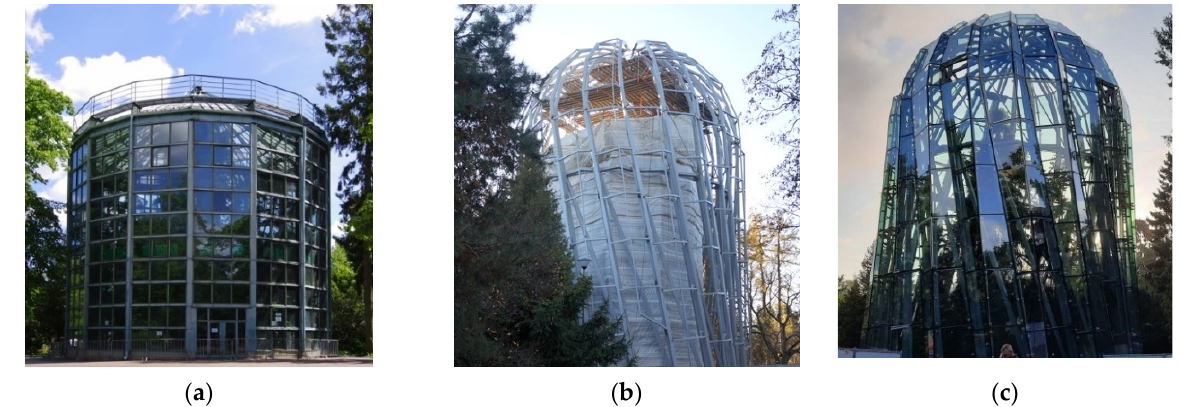
Figure 2. ( a ) Palm house prior to its reconstruction, 2017; ( b ) during the reconstruction, 2018, measurement and construction process inspection period; ( c ) the glazed and commissioned building [66] (Reproduced with permission from Dyrekcja Rozbudowy Miasta Gdanska).